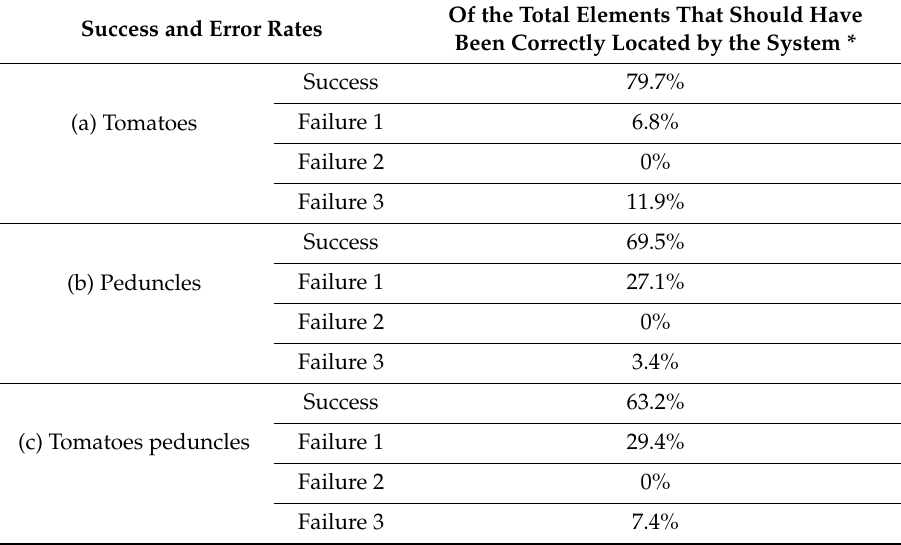
Table 2. Success and error rates for the cluster